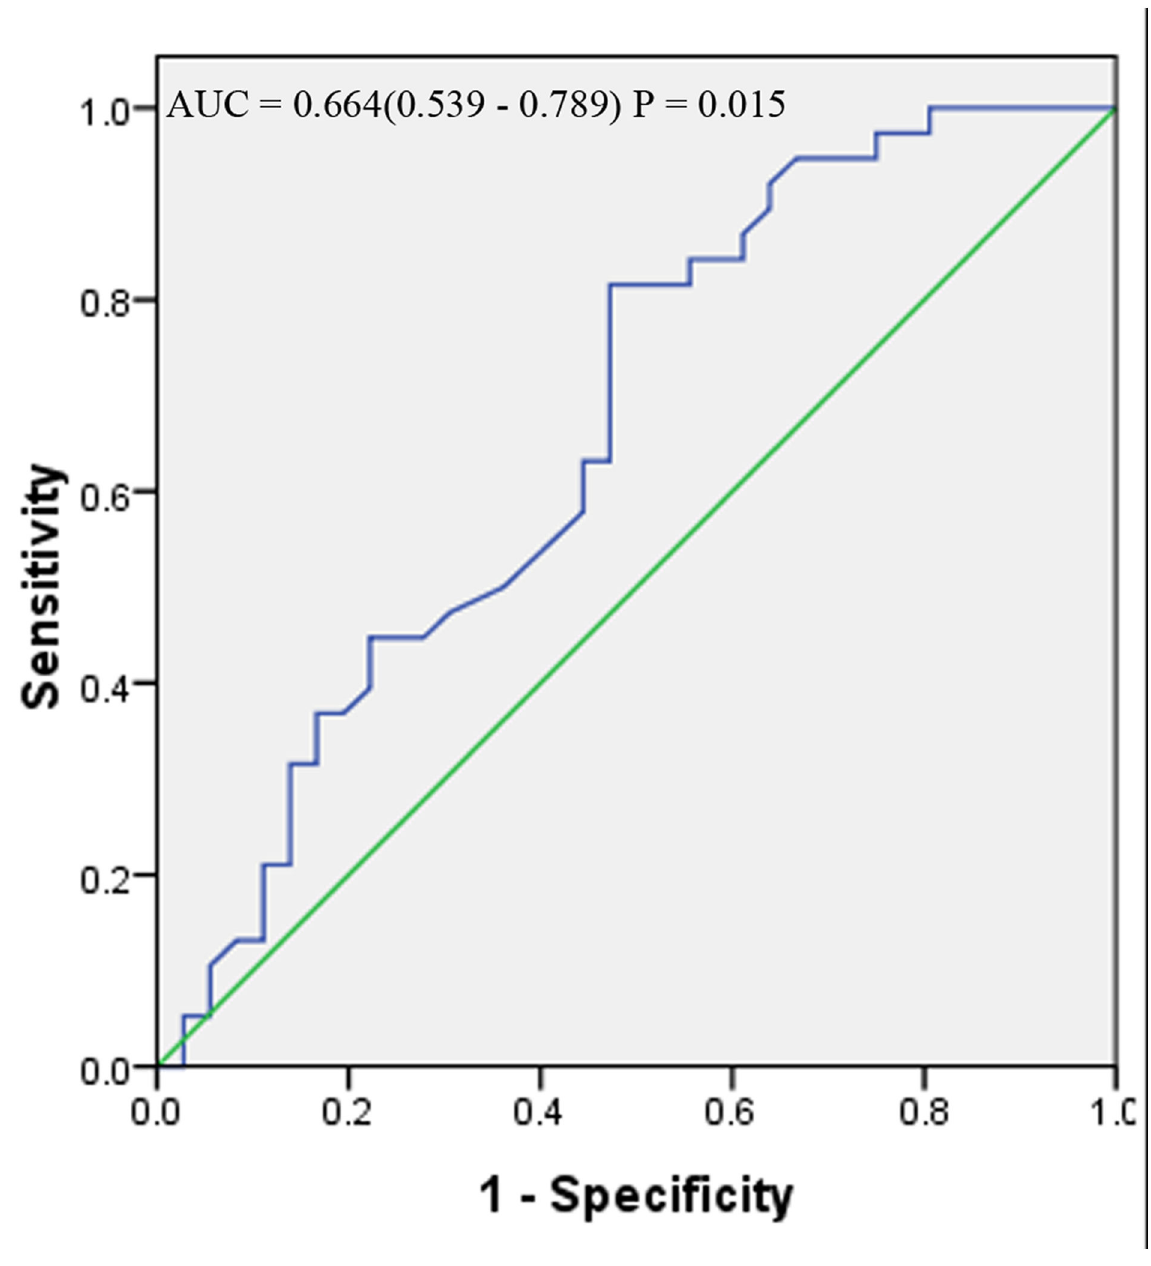
Figure 2. Receiver-operating characteristic (ROC) curve for anthropometric assessment BMI in assessing nutrition status using MIS as the reference standard. ( *P < 0.05)